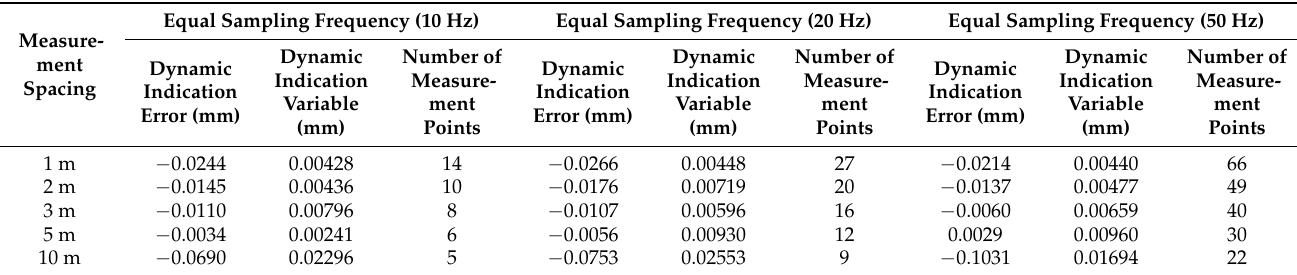
Table 2. The dynamic performance of the laser tracker when measuring at different measurement distances and equal sampling